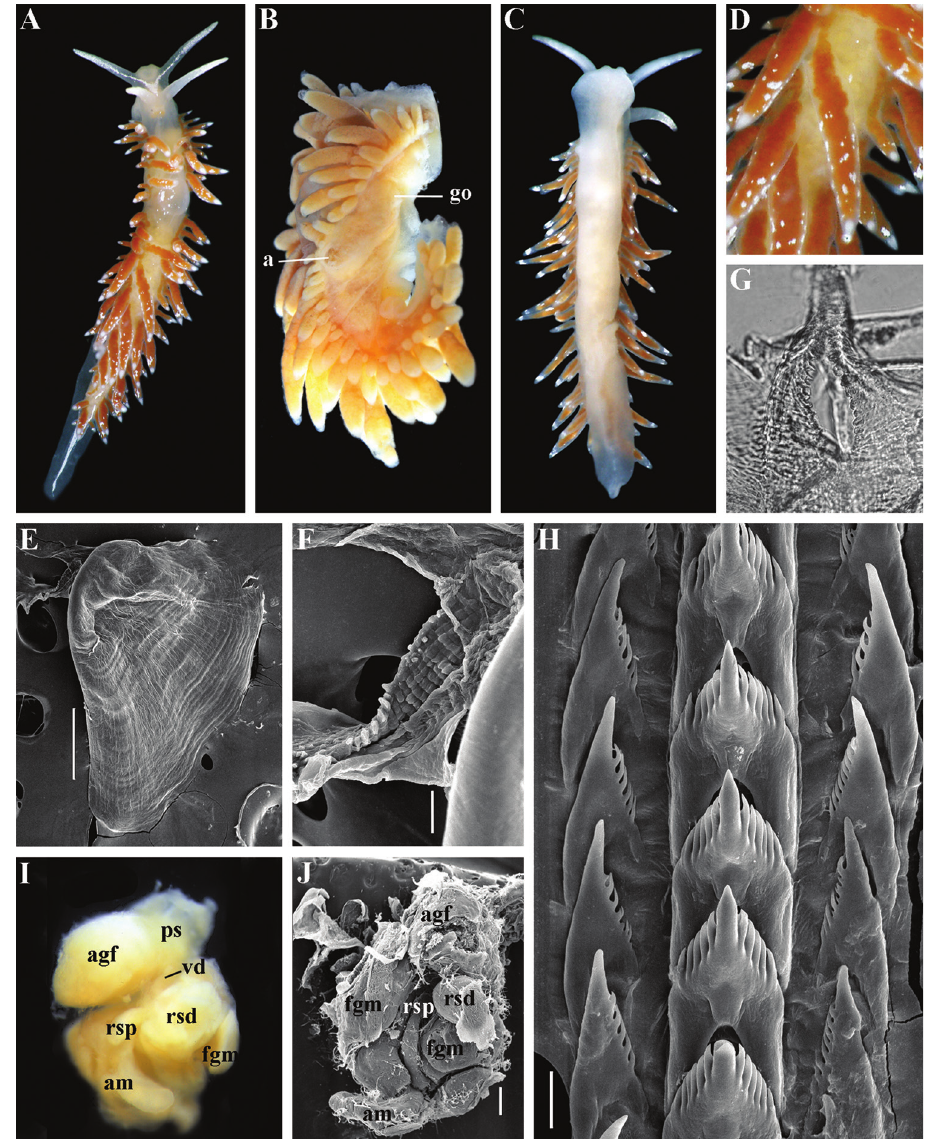
Figure 32. Occidentella athadona (Bergh, 1875), comb. n. North West Pacific, Kamchatka. ZMMU Op- 498, living animal 19 mm length: A dorsal view B lateral view (fixed) C ventral view D details of cerata E jaw, SEM, scale bar = 1 mm F details of masticatory process of jaw, SEM G details of masticatory pro- cess of jaw, light microscopy H radular teeth, posterior part, SEM I reproductive system, light microscopy J reproductive system, SEM. Abbreviations: a anus agf additional glandular formation (modified pros- tate), am ampulla fgm female gland mass go genital opening ps penial sheath rsd distal receptaculum seminis rsp proximal receptaculum seminis vd vas deferens (very rudimentary, rapidly transits to greatly enlarged modified prostate ( agf ). Scale bars: E = 1 mm; F, H = 30 μm; J = 300 μm. Photos and SEM im- ages by T.A. Korshunova, A.V.